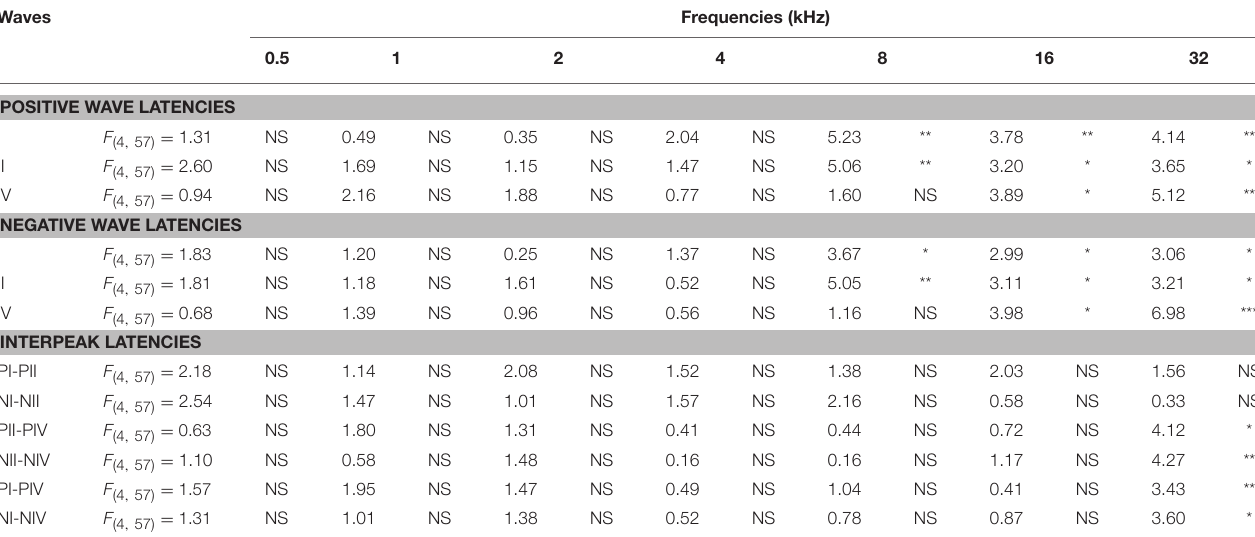
TABLE 4 | ANOVA analysis of the interaction between the time post-exposure and the wave latencies. Waves